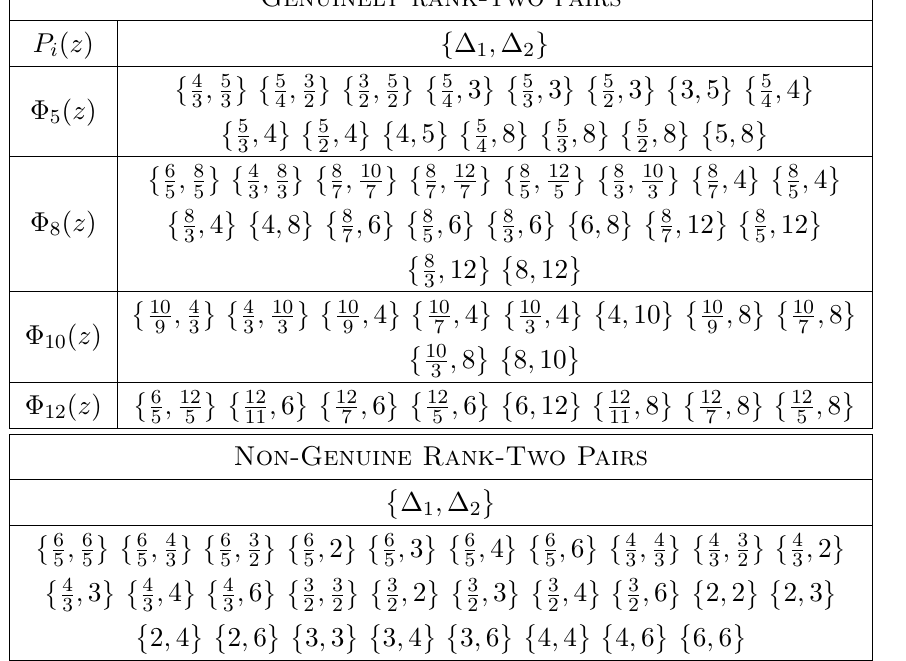
Table 5 . Full list of allowed pairs of scaling dimensions at rank-two. The genuinely rank-two pairs are those which include at least one entry which is not allowed at rank-one. In the first column we report the form of the characteristic polynomial where Φ